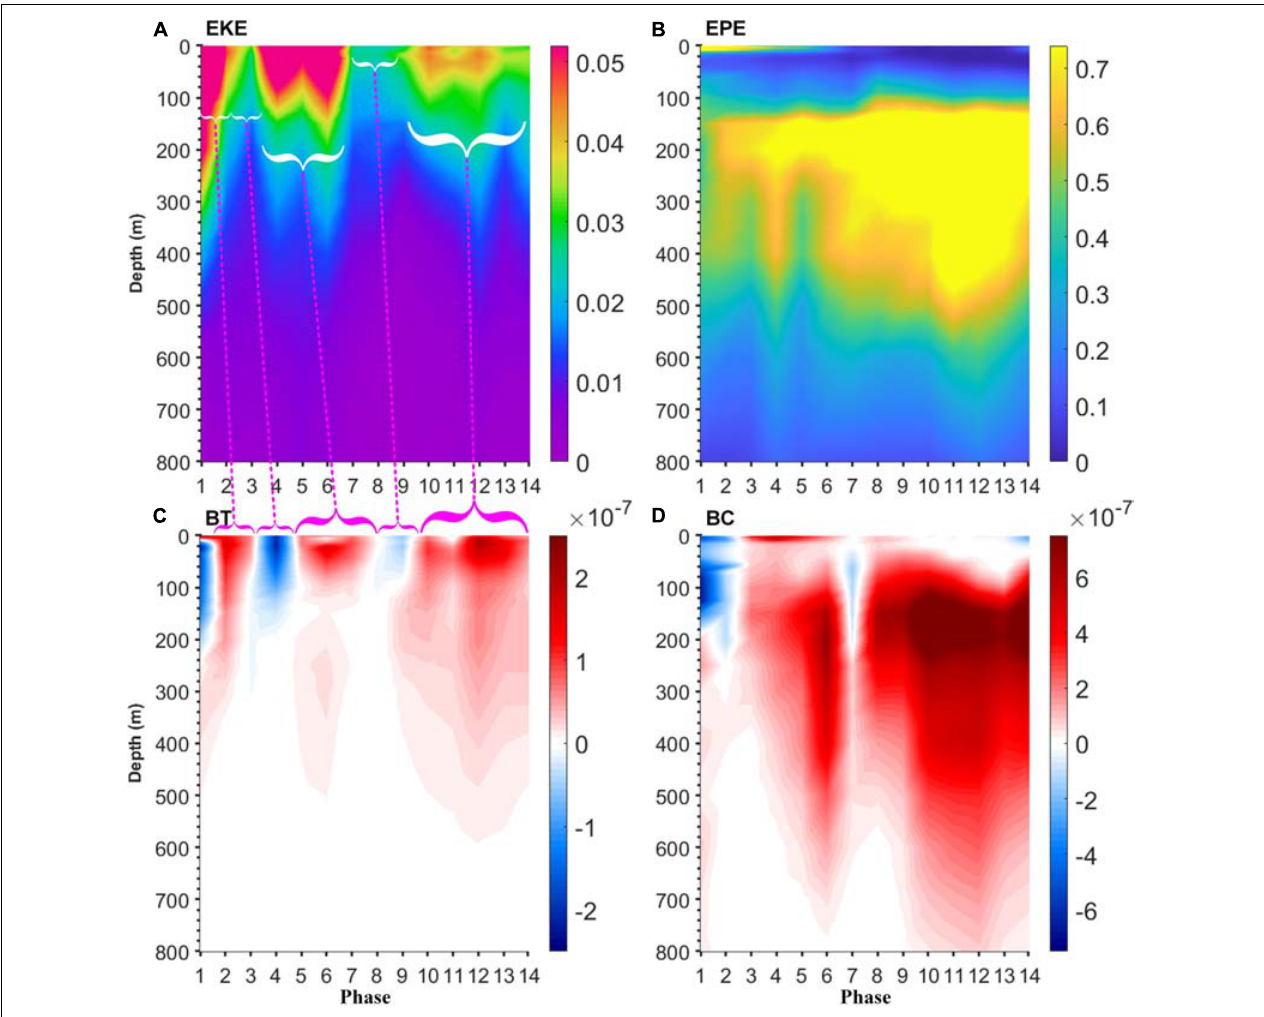
FIGURE 11 | Vertical distributions of (A) EKE (unit: m 2 /s 2 ), (B) EPE (unit: m 2 /s 2 ), (C) BT (unit: m 2 /s 3 ), and (D) BC (unit: m 2 /s 3 ) averaged horizontally over the effective eddy regions during phases 1–14 (April 9 to July 15, 2017). There is a correspondence between (A,C) , as illustrated by the dashed magenta lines.